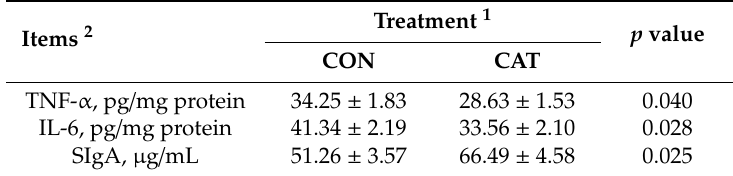
Table5. E ff ectsofdietaryexogenouscatalasesupplementationonthejejunummucosalproinflammatory cytokines and SIgA of weaned piglets. Items 2